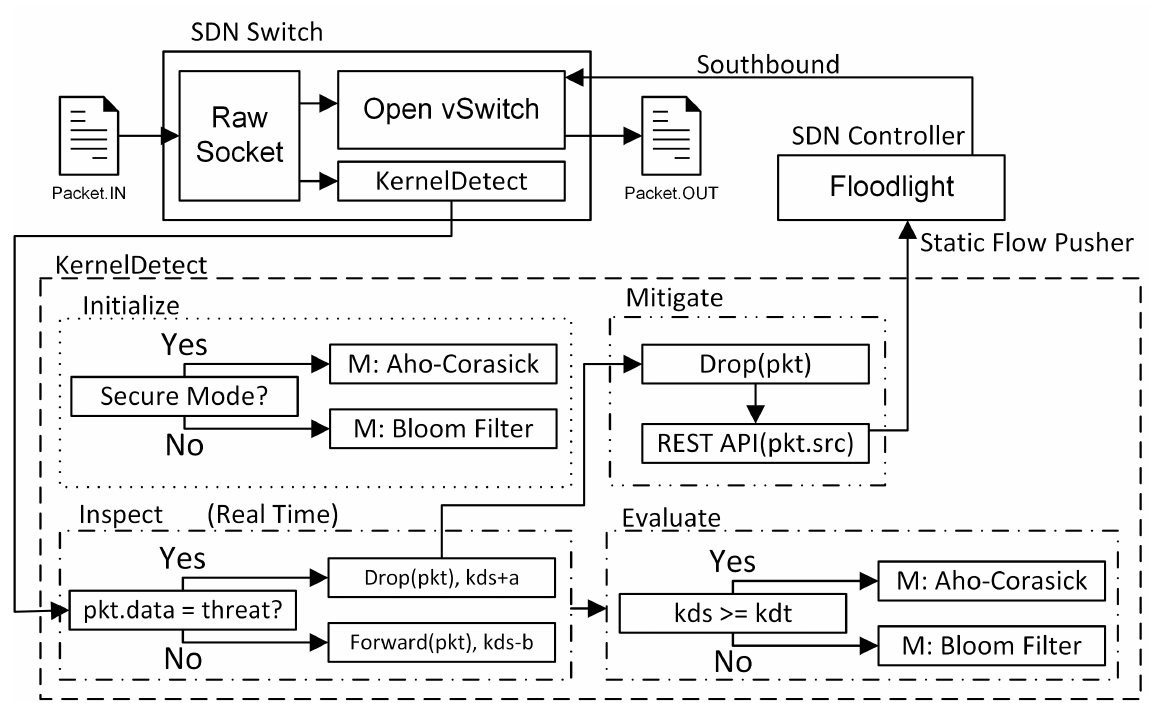
Figure 2. The architecture of KernelDetect consisting of four states: “Initialize," the beginning state of the SDN switch operations, “Inspection," a real-time inspection of traffic obtained from the raw socket of the operating system, “Mitigation," a critical step to thwart an attack and to prevent false positive events carefully, and “Evaluation," the examination of incoming traffic through ‘Aho-Corasick’ or ‘Bloom filter’ with a global view of the